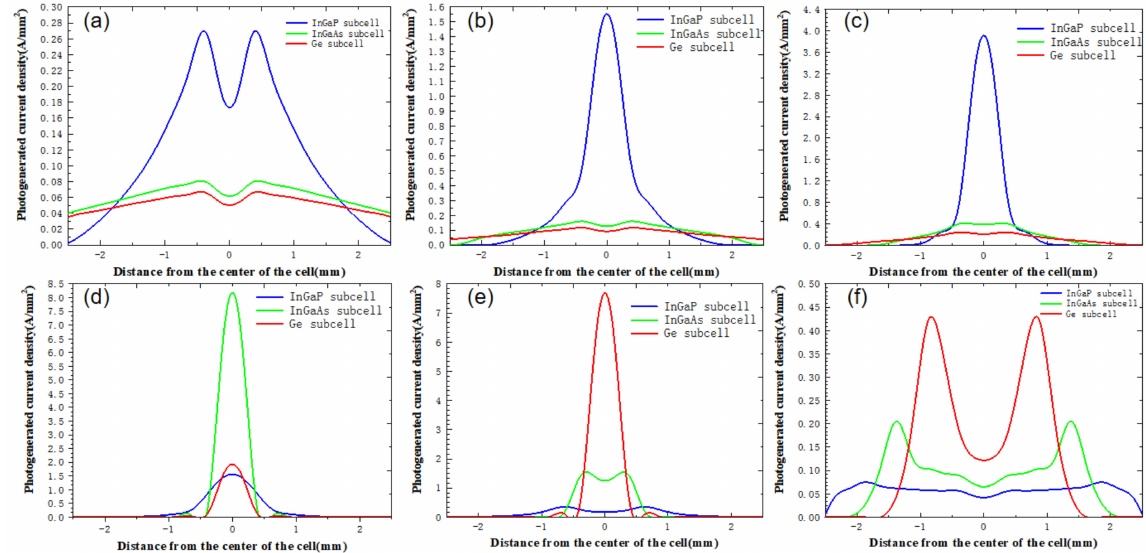
Figure 8. Photogenerated current density in the cell width direction at different optical axis positions. ( a ) Z = 108 mm; ( b ) Z = 109 mm; ( c ) Z = 110 mm (focal plane); ( d ) Z = 111 mm; ( e ) Z = 112 mm; ( f ) Z = 114